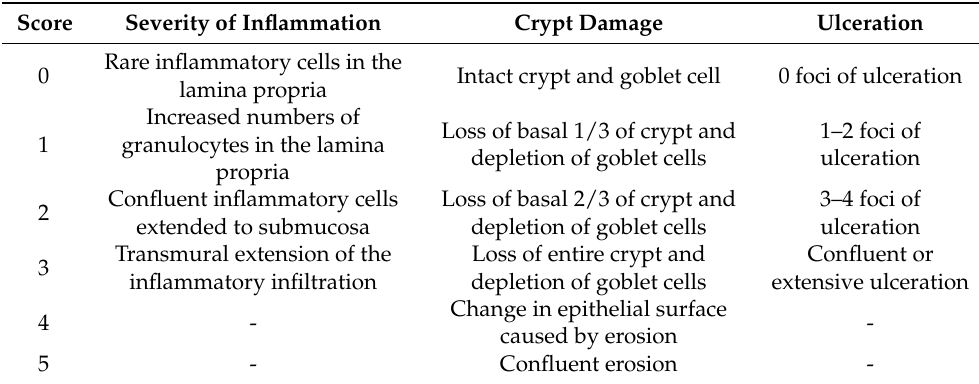
Table 2. Standard of the histopathological